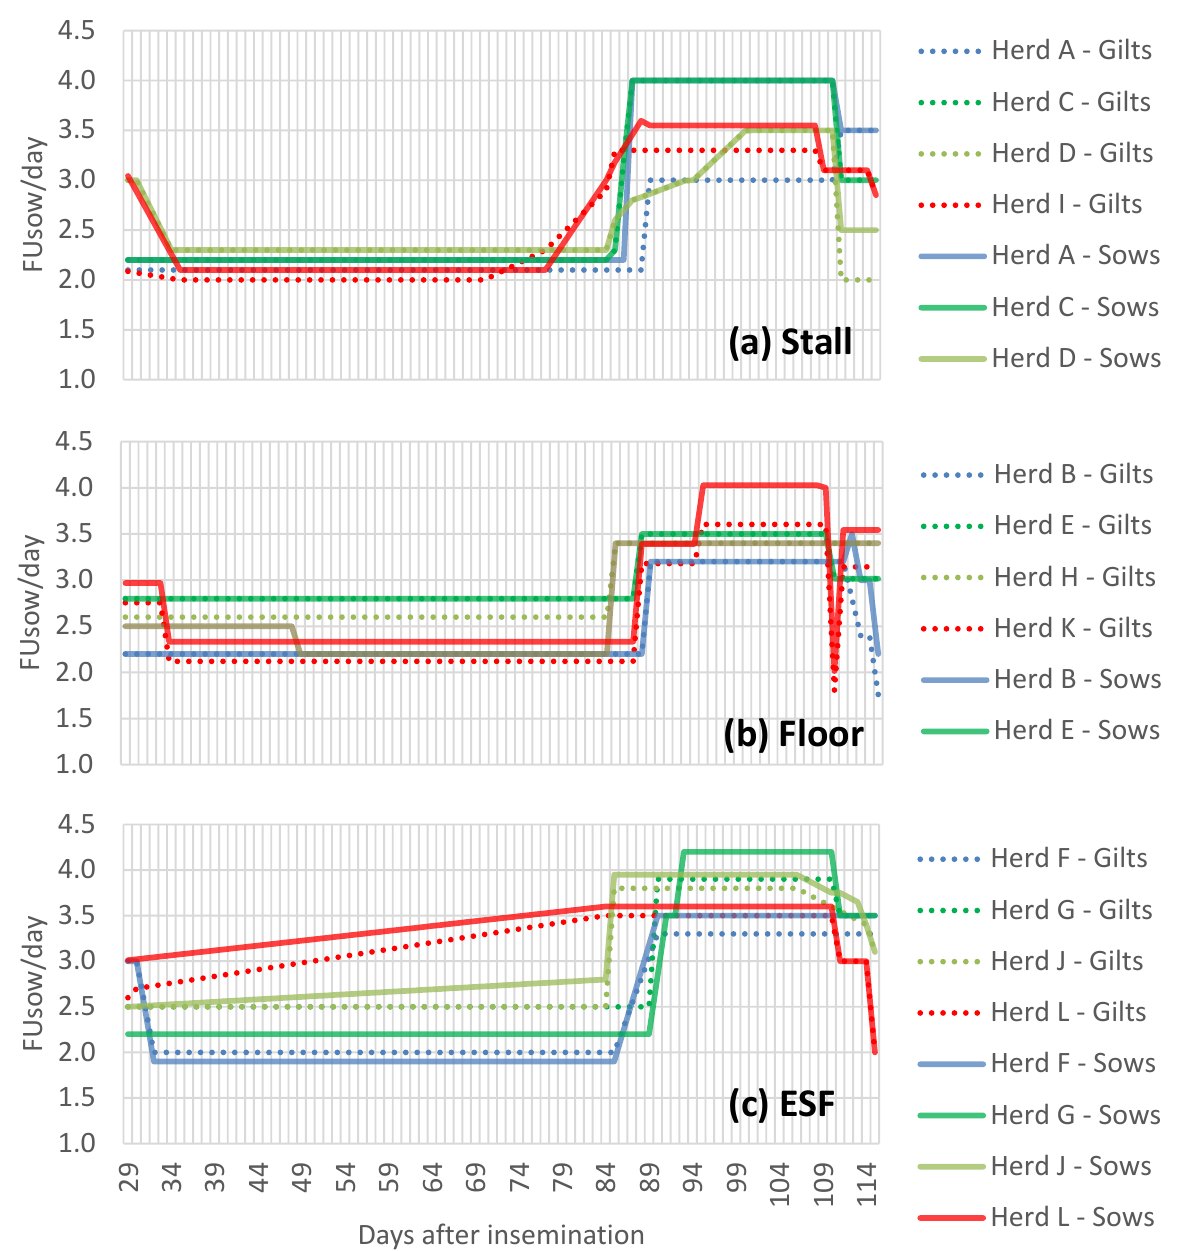
Figure 1. Feeding levels from day 29 to 115 of gestation for gilts and sows of normal body condition at the individual herds of the different feed systems ( a – c ). Stall describes free-access stalls, Floor describes floor feeding and ESF describes electronic sow feeding